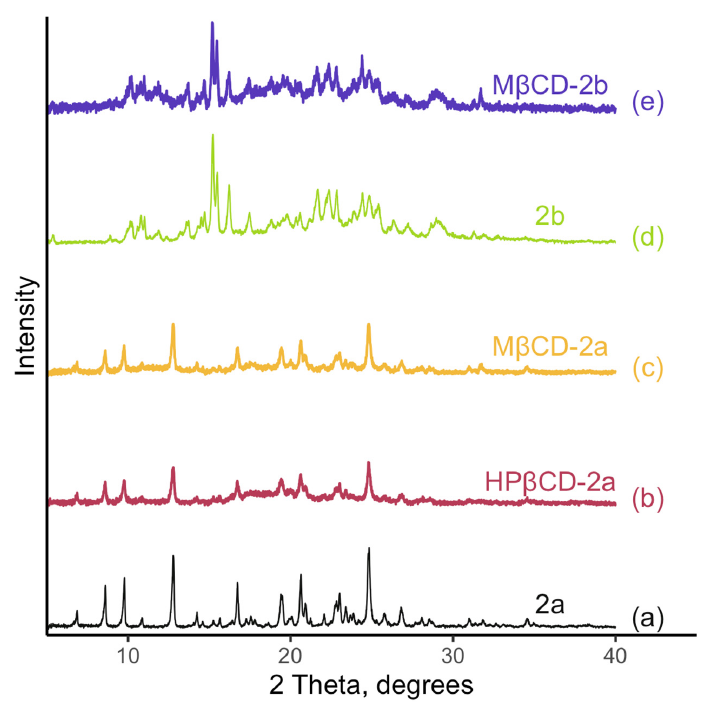
Figure 8. PXRD patterns for ( a ) 2a ; ( b ) HP β CD- 2a ; ( c ) M β CD- 2a ; ( d ) 2b ; ( e ) M β CD- 2b . No signals were observed at 40 − 80°.